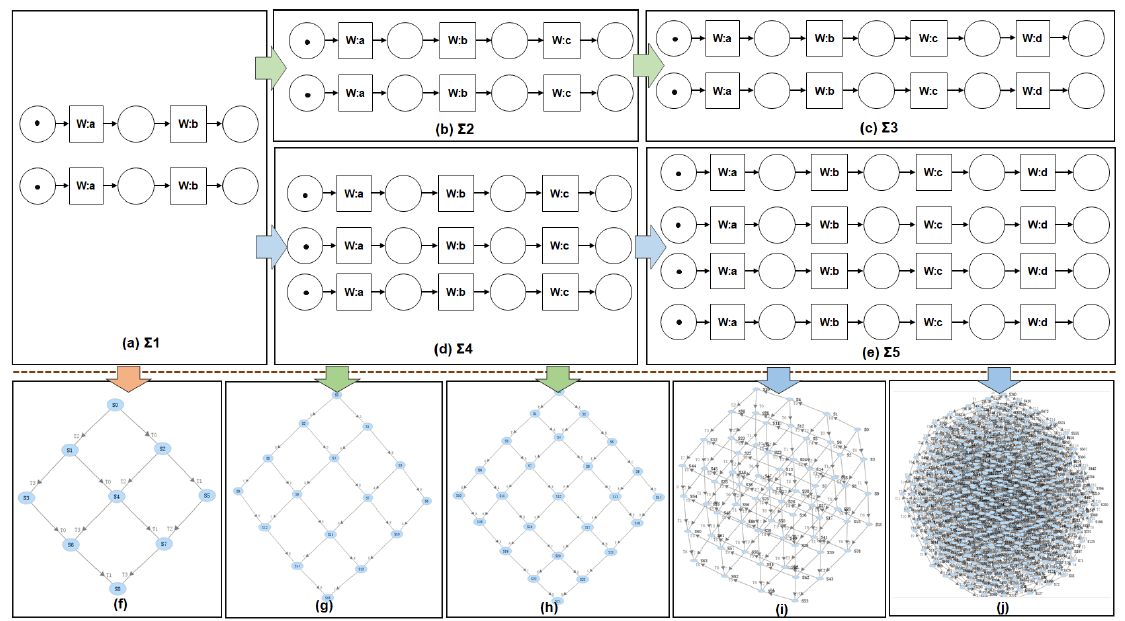
Figure 1. The state–space (reachability graphs) of WFD-nets and state–space explosion problems. ( f ) is the reachability graph of Σ 1 in ( a ); ( g ) is the reachability graph of Σ 2 in ( b ); ( h ) is the reachability graph of Σ 3 in ( c ); ( i ) is the reachability graph of Σ 4 in ( d ); and ( j ) is the reachability graph of Σ 5 in ( e